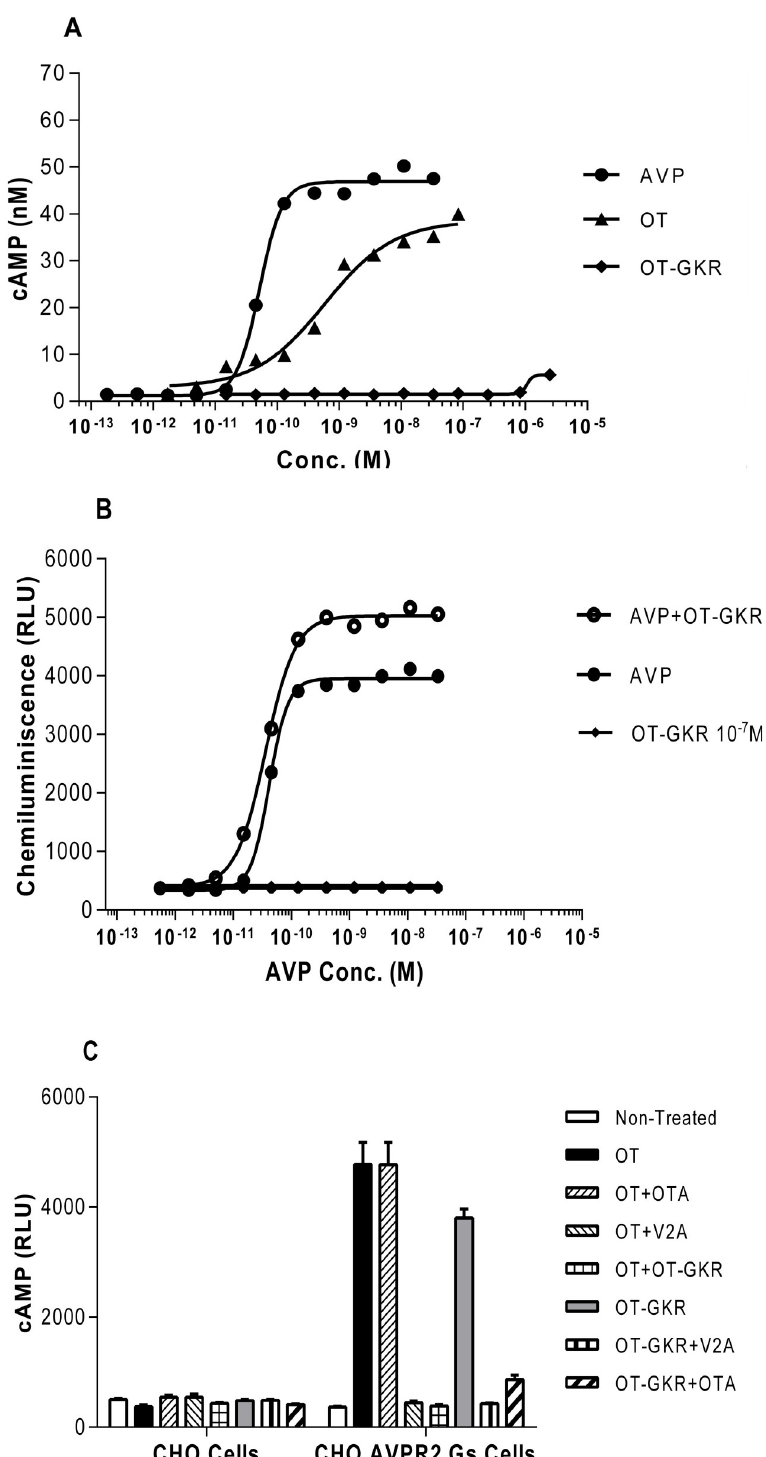
Fig 7. The effects of arginine vasopressin (AVP), oxytocin (OT), and oxytocin extended form (OT-GKR) on intracellular cAMP levels in AVP-R2 CHO-K1 cells. (A) Release of cAMP from AVP-R2 CHO-K1 cells in response to increasing concentrations of AVP, OT, and OT-GKR. (B) Release of cAMP from AVP-R2 CHO-K1 cells treated with AVP as antagonist and in combination with OT-GKR used as agonist. OT-GKR was added in AVP-R2 CHO-K1 cells at the concentration of 10 -7 M. (C) Release of cAMP from control CHO cells and AVP-R2 CHO-K1